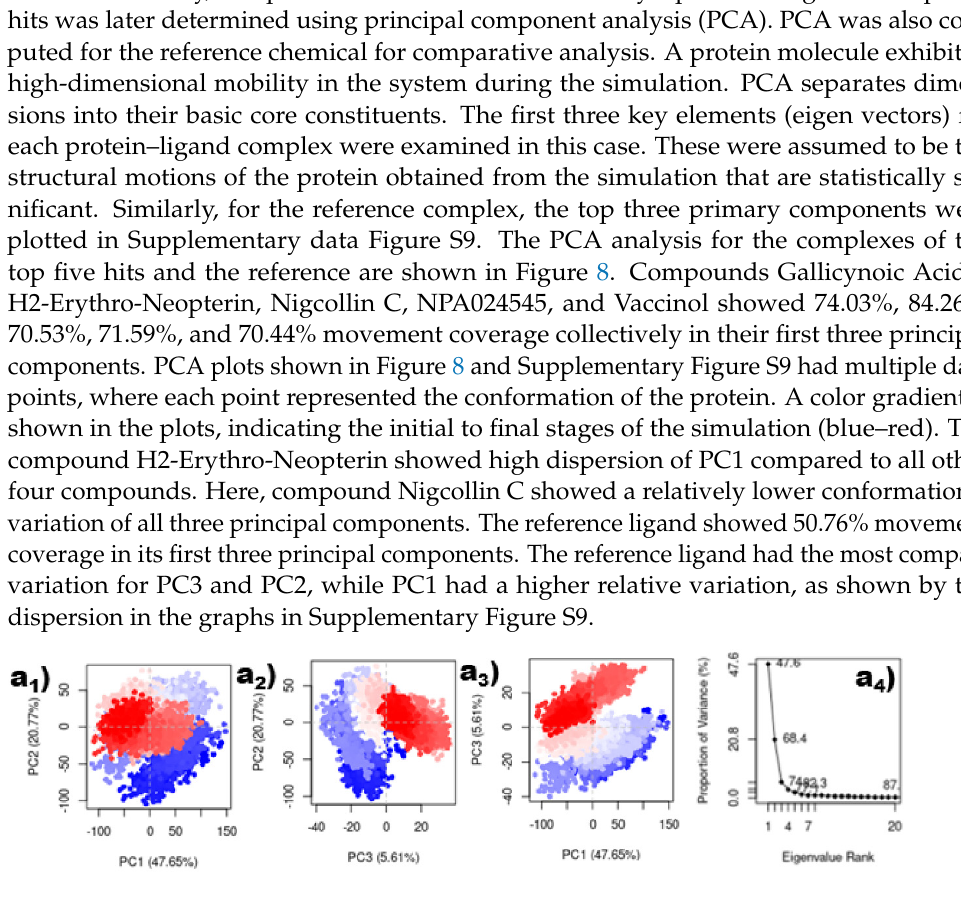
Figure 8. Principal component analysis of top five compounds. ( a ) Gallicynoic Acid F, ( b ) H2 ‐ Erythro ‐ Neopterin, ( c ) Nigcollin C, ( d ) NPA024545, and ( e ) Vaccinol.